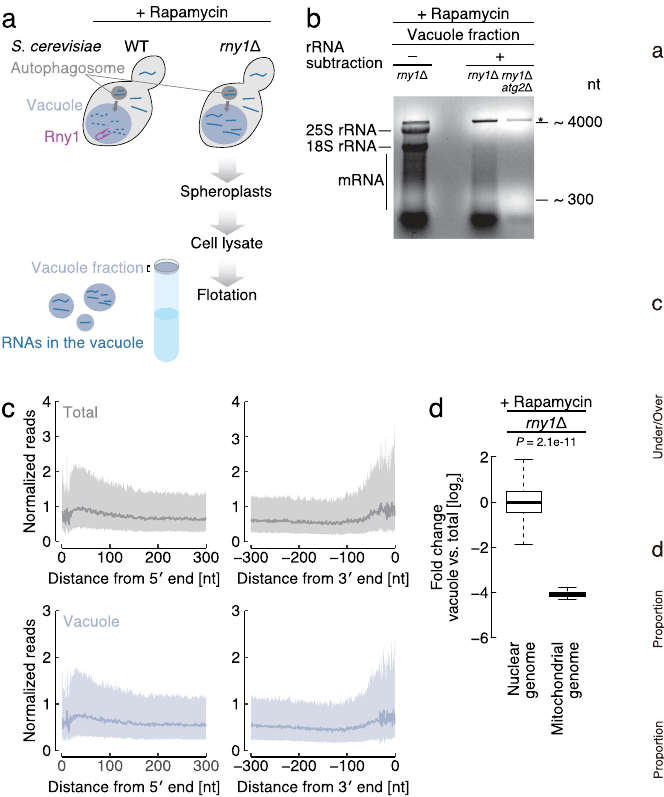
Fig. 1 Determination of the autophagy-dependent vacuolar transcriptome. a Schematic illustration of the experimental design. Following the induction of autophagy by 3 h rapamycin treatment, vacuoles from yeasts were puri fi ed by ultracentrifugal fl otation. A strain deleted for the vacuolar nuclease Rny1, which degrades nucleic acids within the vacuole, was used. b Autophagy-dependent mRNA accumulation in the vacuole fraction. Agarose gel electrophoresis image of RNAs detected in the vacuole fraction of rapamycin-treated (3 h) cells. rRNA subtraction was performed by treating extracted RNA samples with oligonucleotides complementary to rRNAs. Representative results from three independent experiments are shown. Asterisk indicates a nonspeci fi c band. c Meta-gene analysis for mRNA-Seq read distributions around the 5 ′ and 3 ′ ends of transcripts from whole-cell lysate (gray) or vacuole fraction (purple). The 5 ′ end of reads is depicted. The line and shaded area represent the median and interquartile range, respectively. d Change in mitochondrial genome- encoded mRNAs ’ enrichment in vacuoles versus total cellular extracts following 3 h rapamycin treatment. Box plots show the accumulation of reads originating from nuclear and mitochondrial genomes, as determined by RNA-Seq. The median, interquartile range (IQR), and 1.5 IQR are represented by a solid line, box, and whiskers, respectively. Signi fi cance was determined by unpaired two-sided Mann-Whitney U-test.